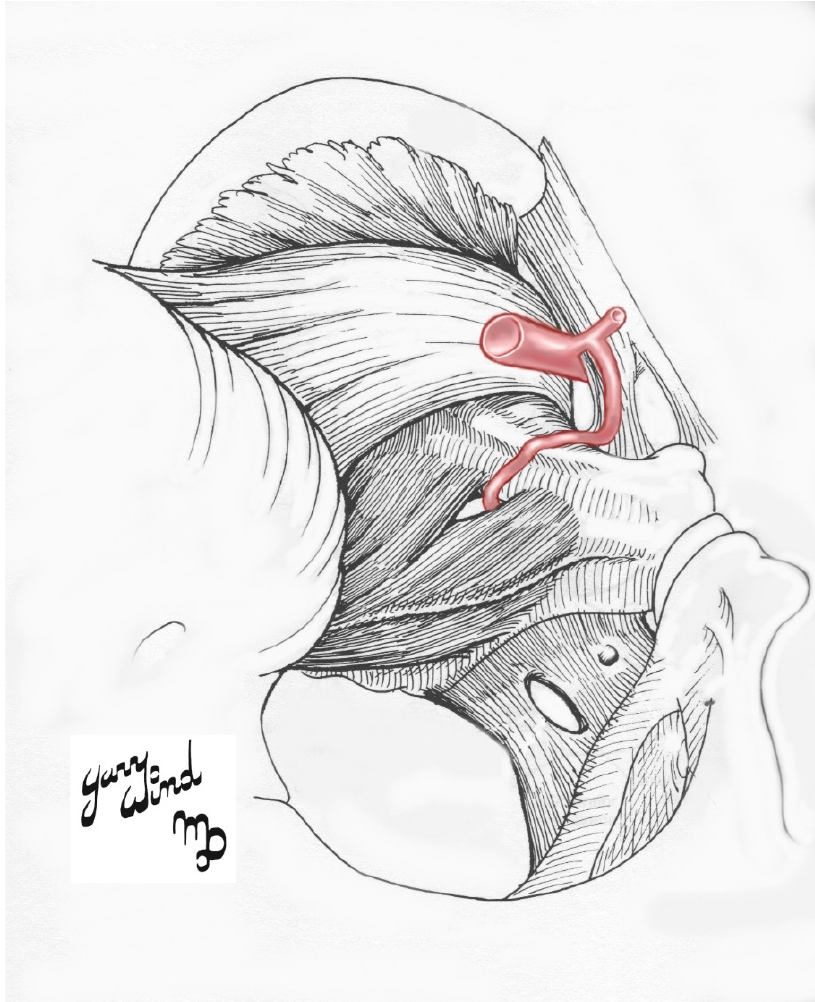
Figure 1. Illustrative schematic of the most common type of the aberrant obturator